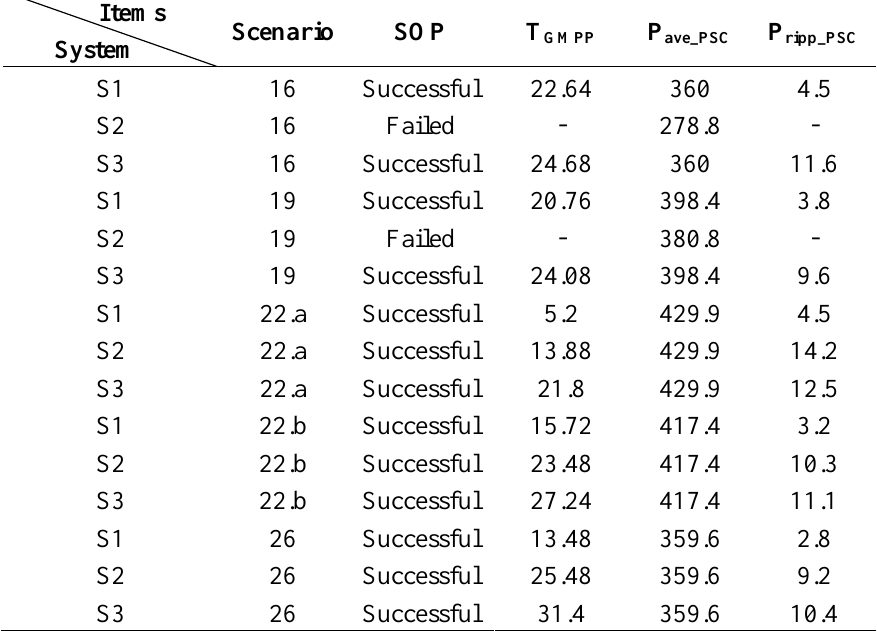
Table 4. The experimental results for S1, S2 and